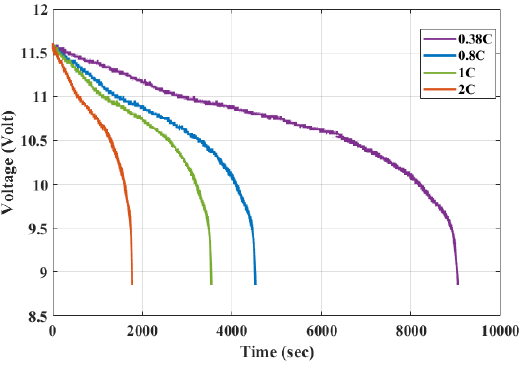
Figure 17. Discharging curves at 0.38 C of 26th cycle, 0.8 C of 24th cycle, 1 C of 21st cycle, and 2 C of 29th cycle.